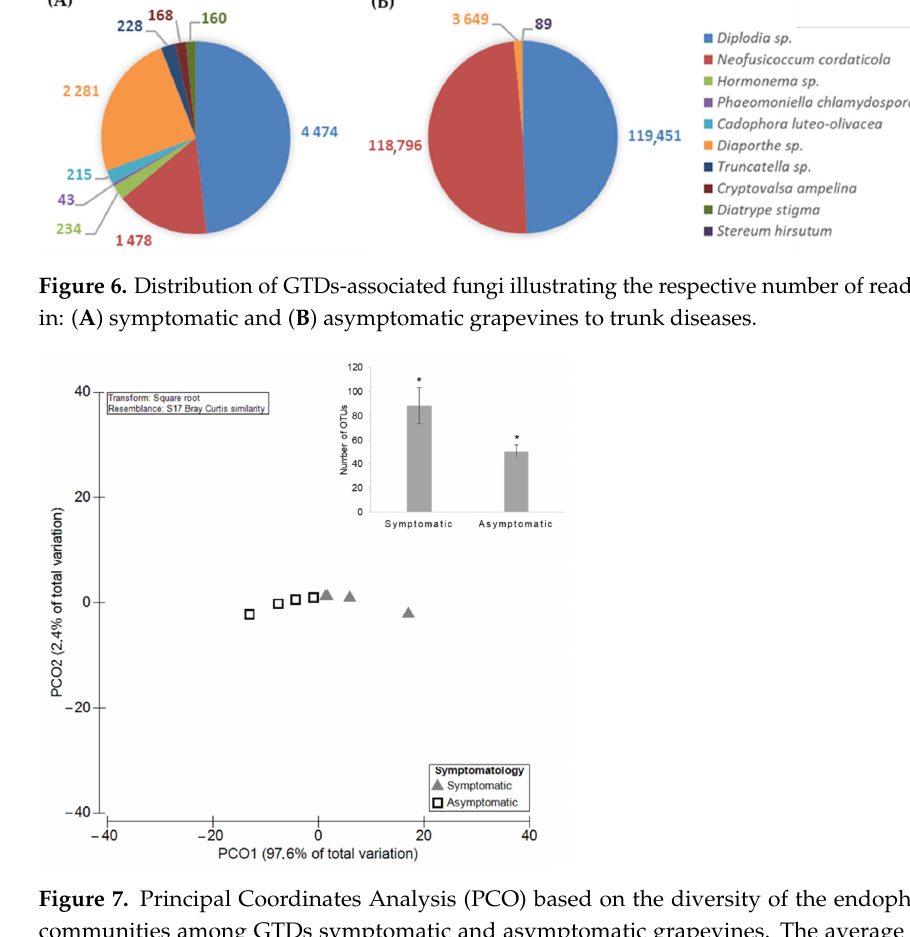
Figure 7. Principal Coordinates Analysis (PCO) based on the diversity of the endophytic fungal communities among GTDs symptomatic and asymptomatic grapevines. The average of the total OTUs number for both groups is shown in bar plot and significant differences ( p < 0.05) are indicated by asterisks.